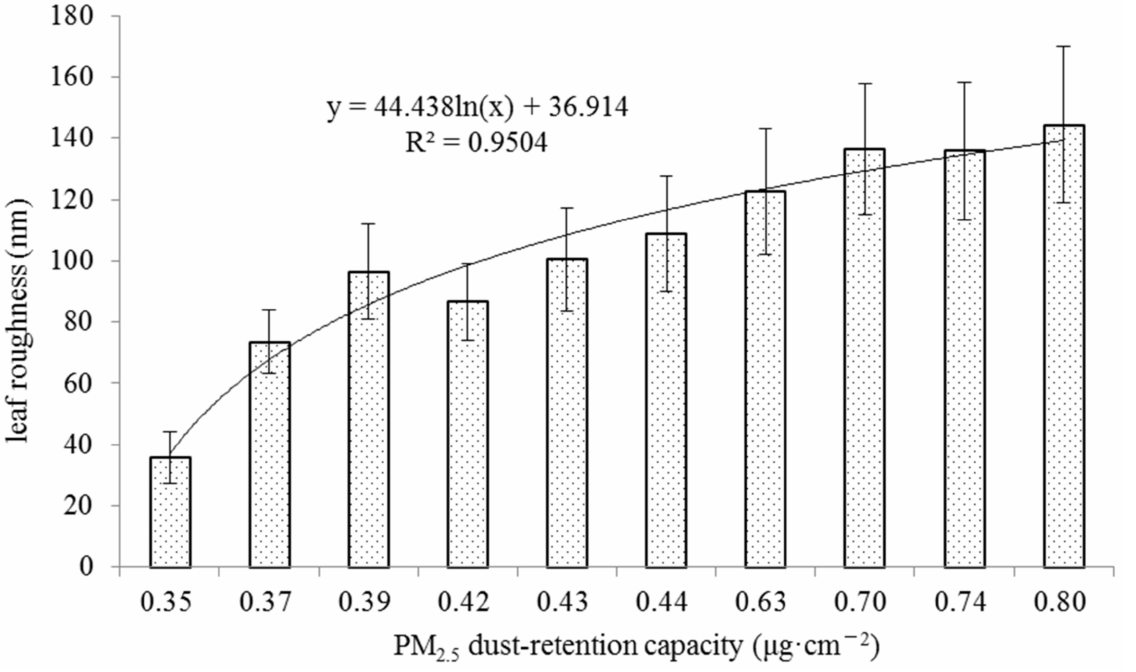
Figure 4. Relationship between PM 2.5 dust-retention capacity and leaf roughness of different tree